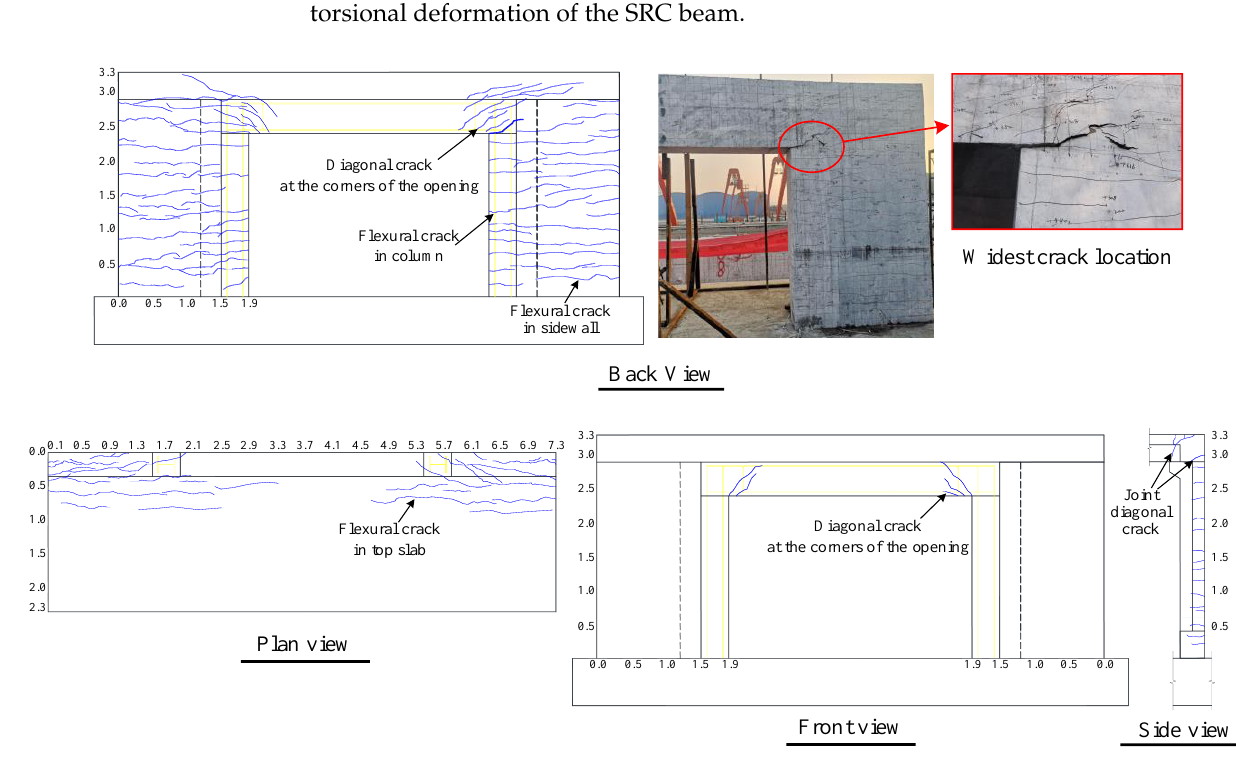
Figure 9. Crack patterns of the specimen (units: m).